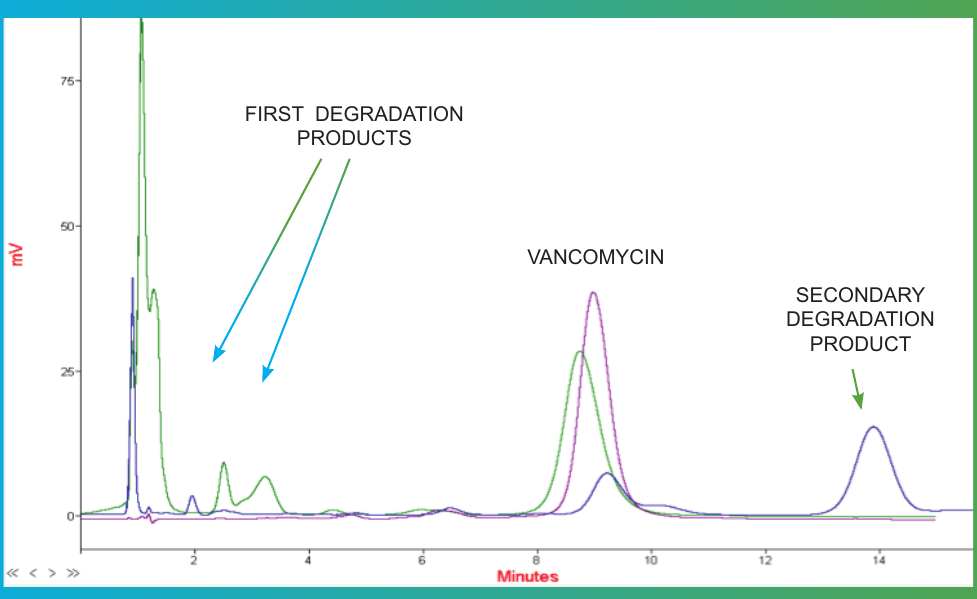
violet curve: 125 µg/ml vancomycin solution before degradation Green curve: vancomycin after 1 hour in contact with a solution of NaOH: partial degradation of the molecule (about 20%) and appearance of the first degradation products Blue curve : vancomycin after 24 hours in contact with a solution of naOH: significant degradation of the molecule. Presence of secondary degradation products but no possible visualisation of the first degradation products. Excessively aggressive treatment – to be